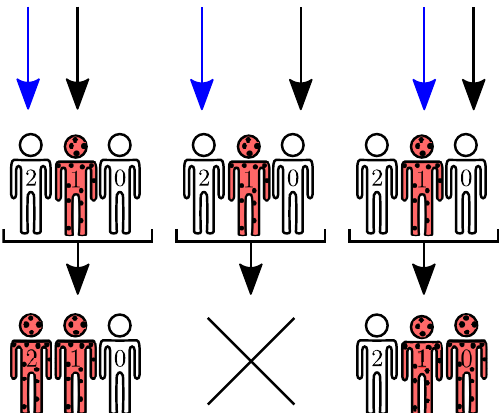
Figure 9. Infection operator action on configuration vector | 2 (cid:105) , in the SIS model with N = 3 and mean field network. Disease transmission events are evaluated for each pair of agents. Whenever the pair health state differs, and the pair also shares one connection expressed by the adjacency matrix, the configuration changes to contemplate the recently infected individual. For | 2 (cid:105) , k = 1 agent contaminates k = 0 ( k = 2) agent, producing the configuration | 3 (cid:105) ( | 6 (cid:105)